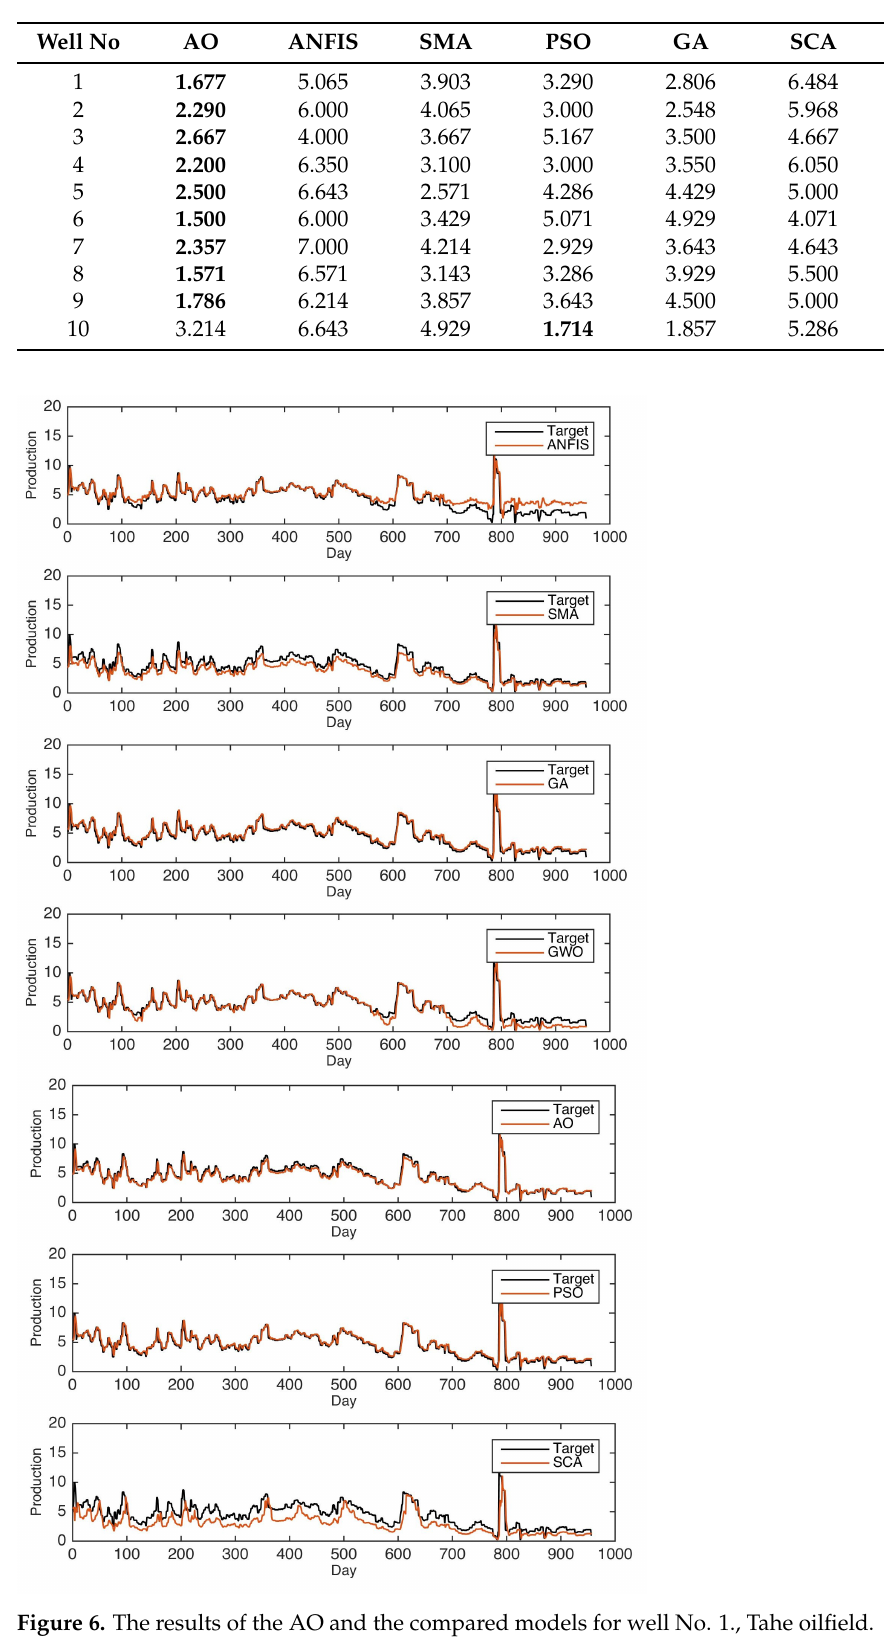
Table 9. The results of the Friedman test for the Tahe oilfield’s dataset using RMSE measure. The best values are shown in bold.